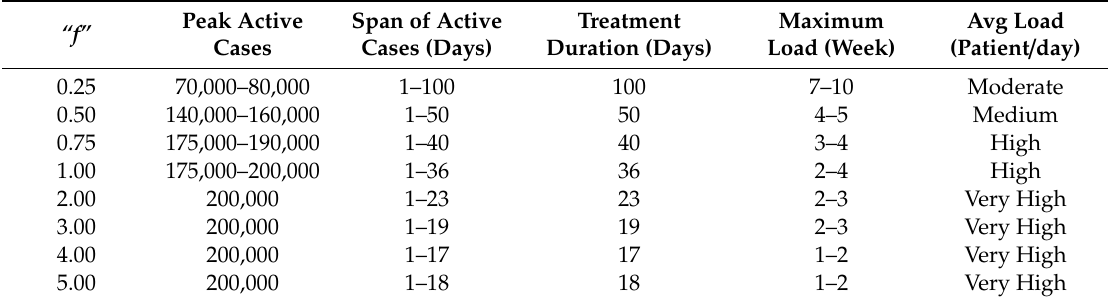
Figure 8. Flattening the distribution graphs of active cases over days by reducing human coronavirus spreading with different “f” values, such as ( a ) f = 0.25; ( b ) f = 0.50; ( c ) f = 0.75; ( d ) f = 1.00; ( e ) f = 2.00; ( f ) f = 3.00; ( g ) f = 4.00; and ( h ) f = 5.00. Table 9. Effect of spreading factor (“f”) to flatten the curve of active cases.